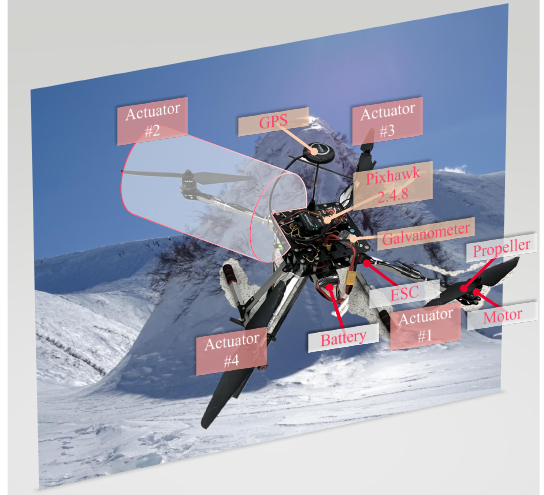
Figure 3. A real drone referenced in the